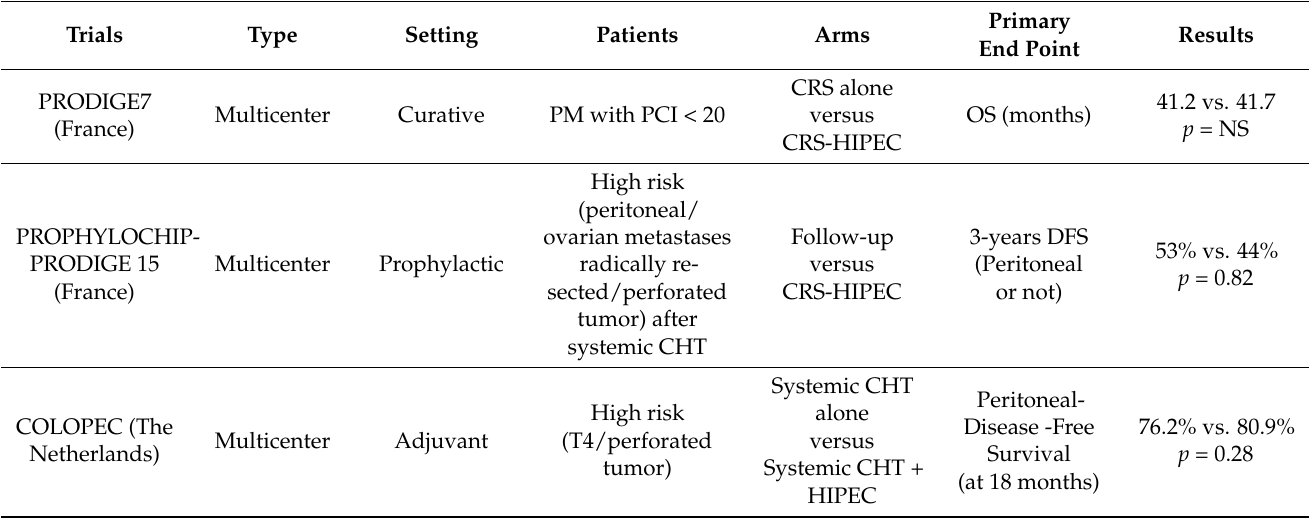
Table 1. Key points of PRODIGE 7, PROPHYLOCHIP-PRODIGE 15, and COLOPEC